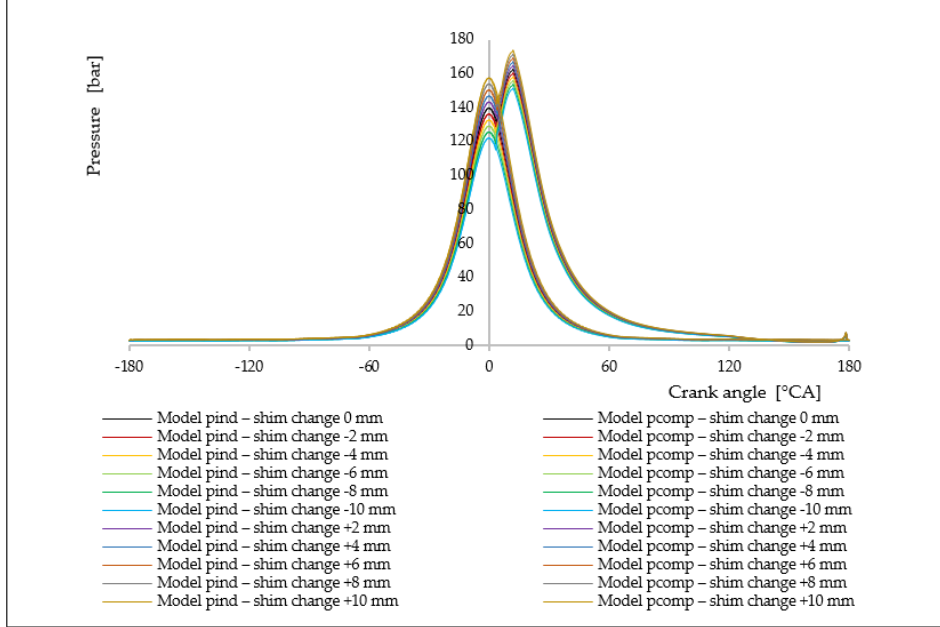
Figure 13. Dependence of combustion and compression pressure on the change in compression ratio at 75% MCR [22].